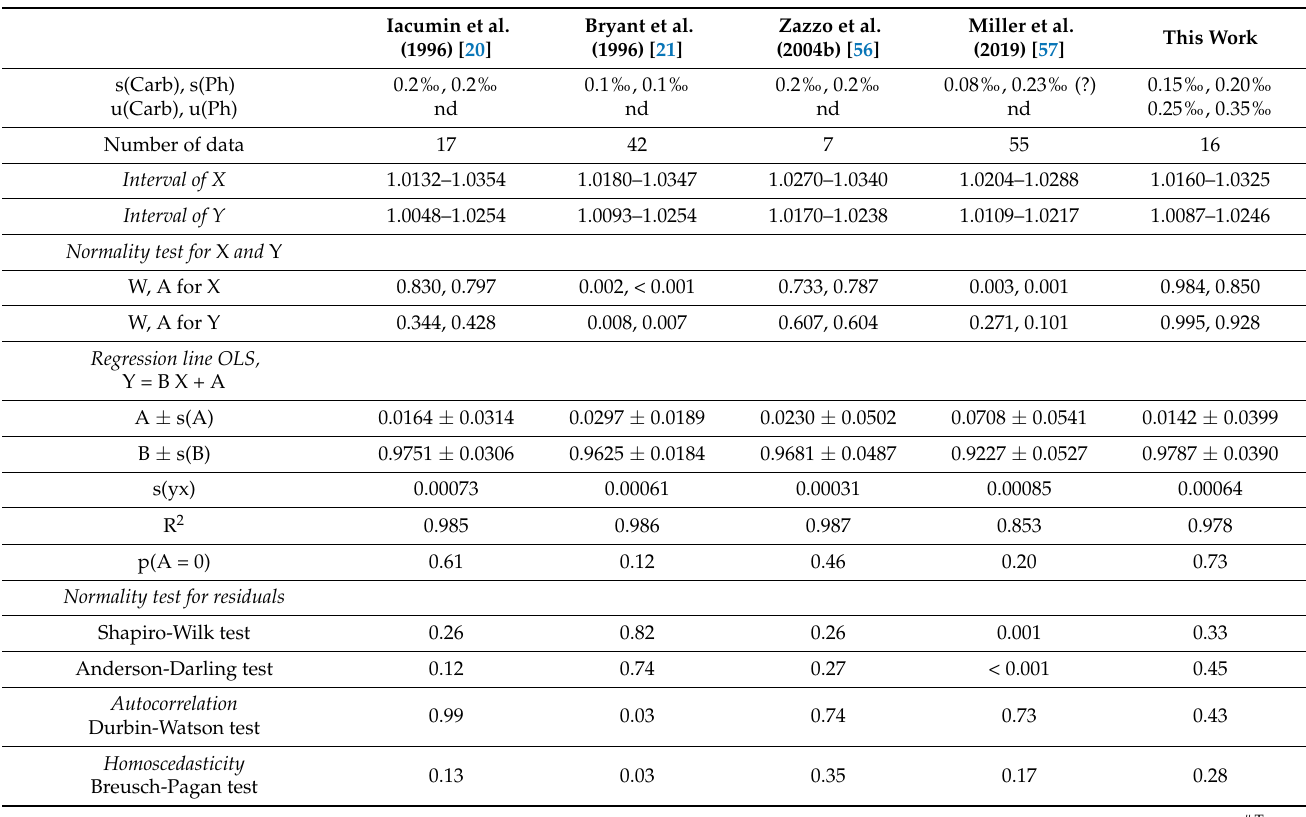
Table 2. Statistical